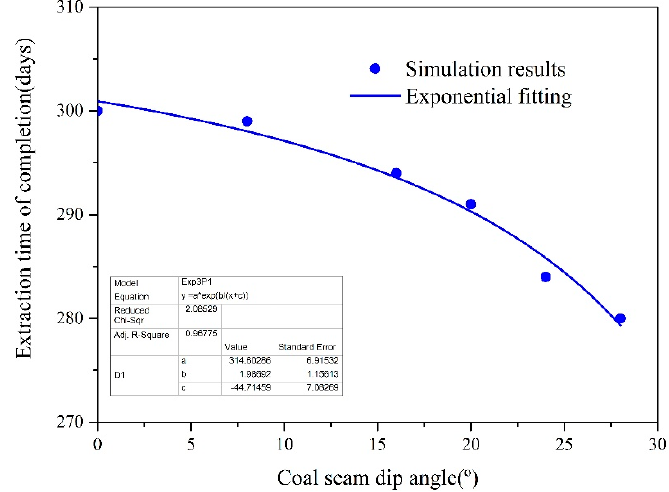
Figure 13. E ff ect of the coal seam dip angle on extraction time of Figure 13. Effect of the coal seam dip angle on extraction time of completion. Figure 13. Effect of the coal seam dip angle on extraction time of completion.